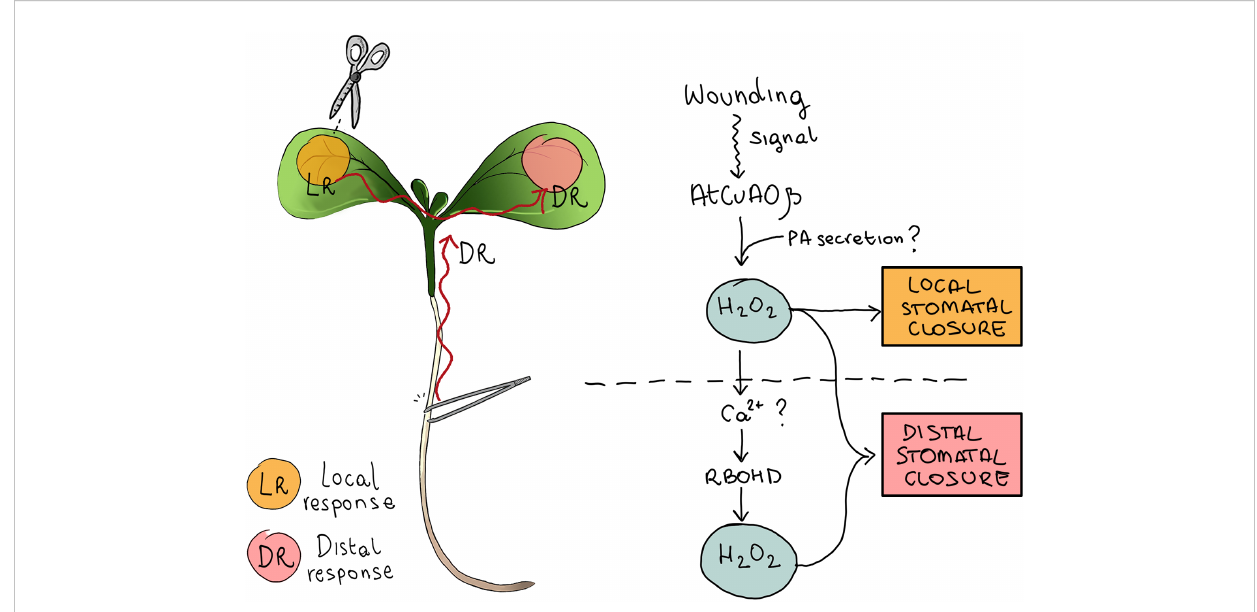
FIGURE 7 Schematic representation of the hypothetical signaling involved in wound-induced stomatal closure. AtCuAO b -mediated PA oxidation in the cell wall of stomatal guard cells triggers local stomatal closure and represents a key step in the early phase of the oxidative burst responsible for systemic stomatal closure. Wound-induced PA secretion in the cell wall could be responsible for the rapid early induction of AtCuAO b -driven oxidative burst. In distal responses, AtCuAO b -driven H 2 O 2 production activates ROS-dependent Ca 2+ channels, thus increasing cytosolic Ca 2+ levels, in turn inducing RBOHD- mediated ROS production, which is an essential component in the oxidative burst of systemic stomatal